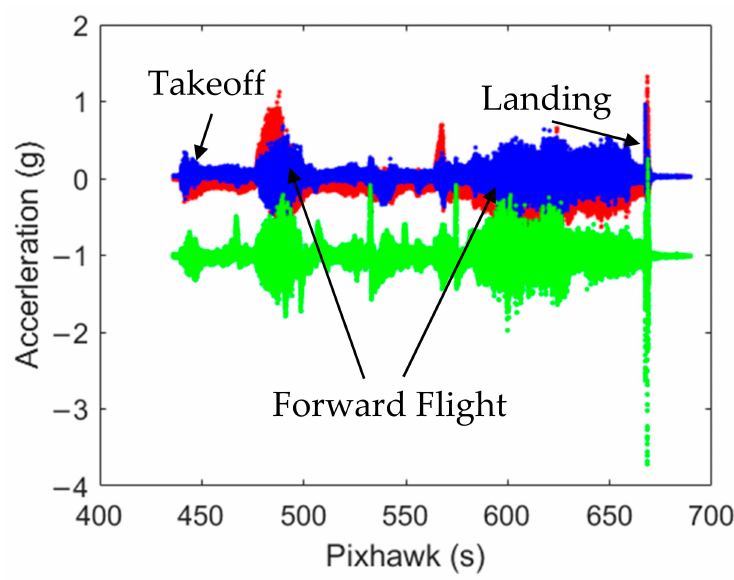
Figure 7. Accelerometer flight data.